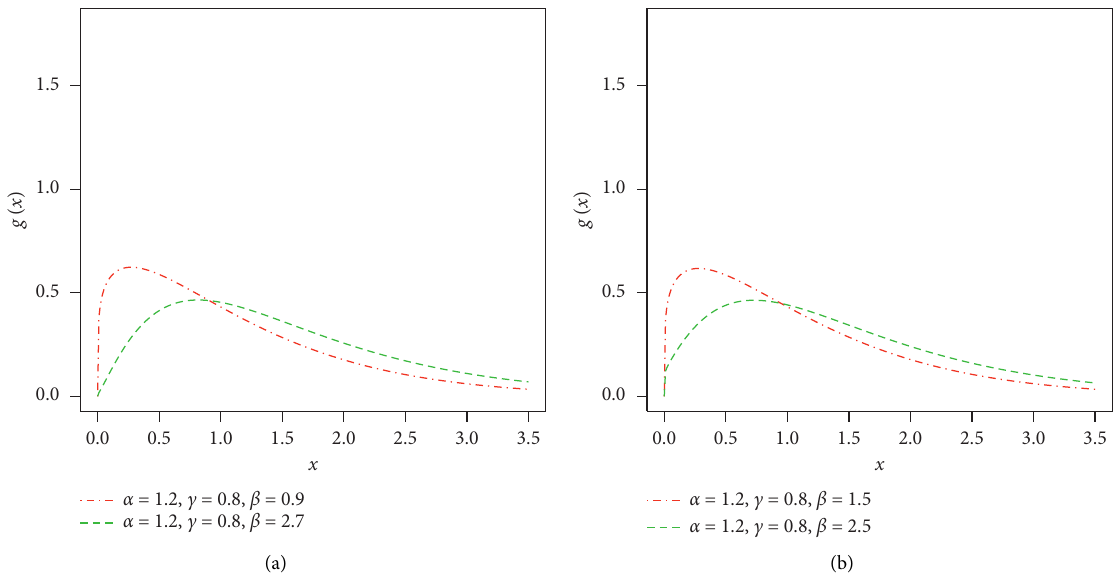
Figure 1: Graphical sketching of the HTBPT–Weibull density function for some parameter